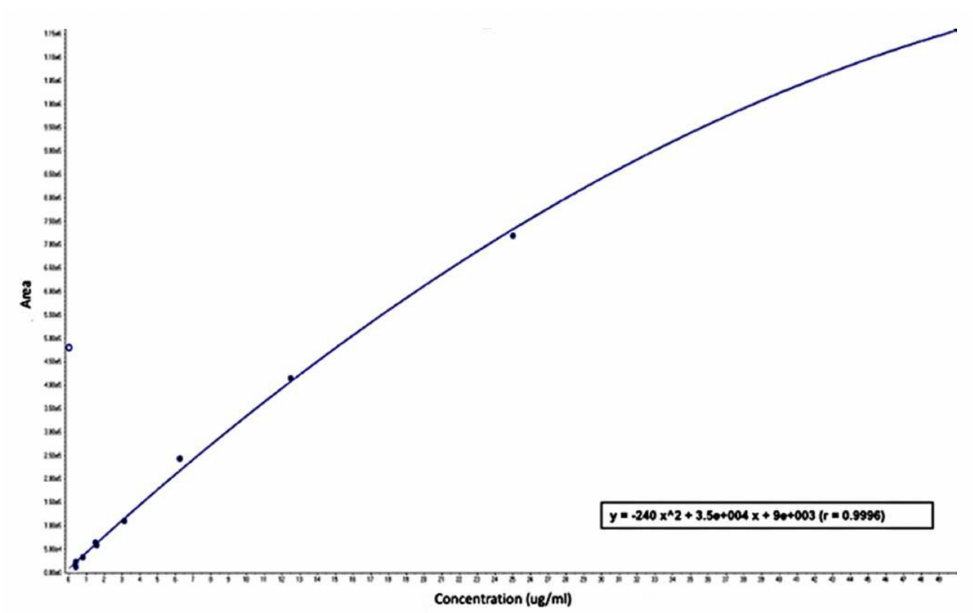
Figure 3. Calibration curve for metformin on concentration range (0.3–50 ug/mL). In the equation: xˆ2 = x 2 and e= 10 3